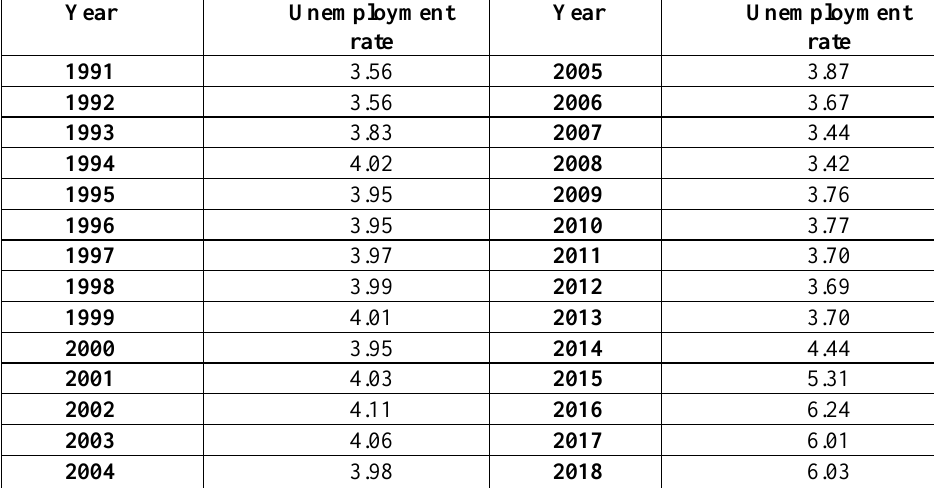
Table 3. The Unemployment Rate in Nigeria from 1999 to 2018 (Data: World Bank,